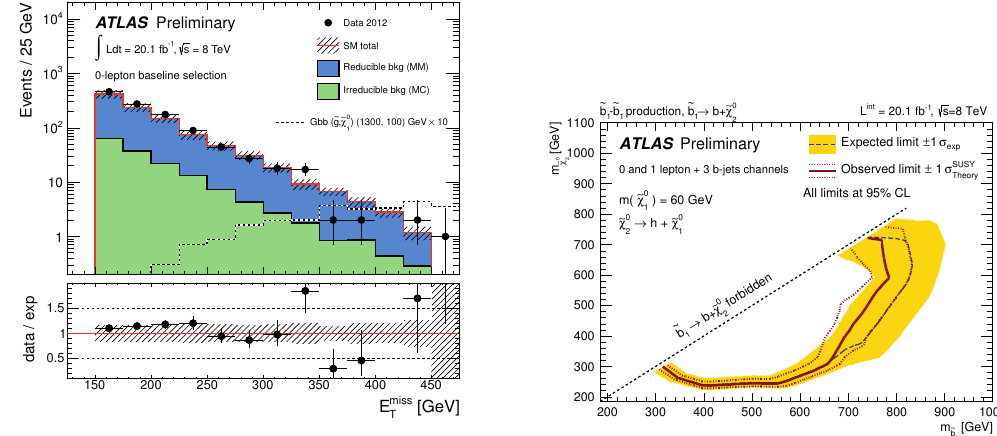
Figure 3: The E miss distribution (left) observed in data after the baseline selection and the requirement T of at least 4 jets with p T > 30 GeV, together with the background prediction. The prediction from the matrix method for the reducible background (MM) is shown in blue and the irreducible background from MC is shown in green. The ratio between the observed event yield and background prediction is also shown. The shaded bands include all systematic uncertainties on the MC and the matrix method predictions. Exclusion limits (right) in the ( m ˜ , m ) plane for the direct sbottom model. [5] ˜ χ 0 2 b 1